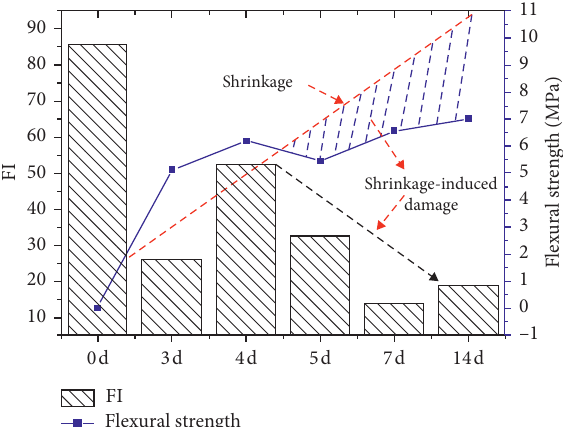
Figure 8: FI of SFP specimen and flexural strength of grouting material with different curing